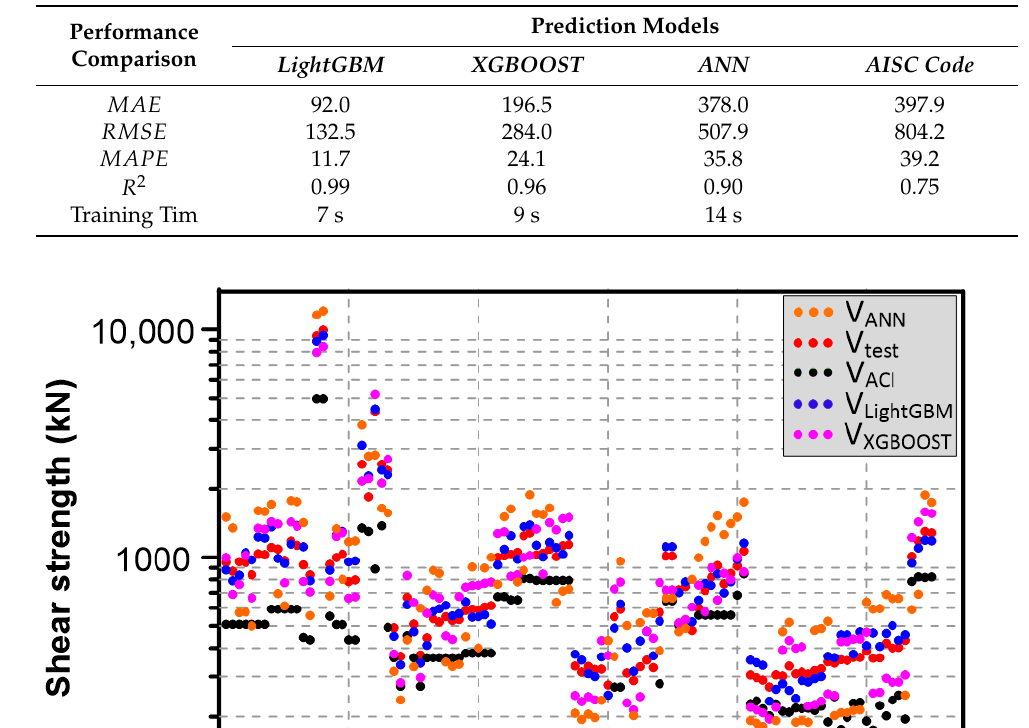
Figure 9. Representation of features importance.